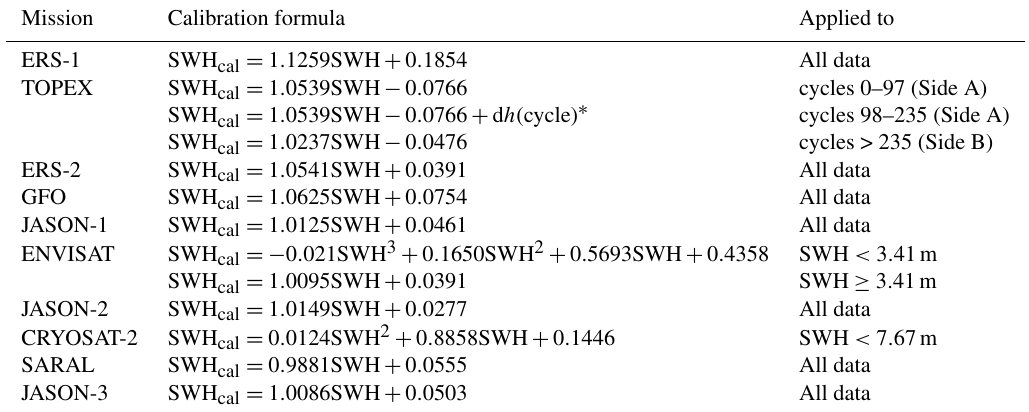
Table 3. Calibration formula used for the Sea State CCI dataset v1. Mission